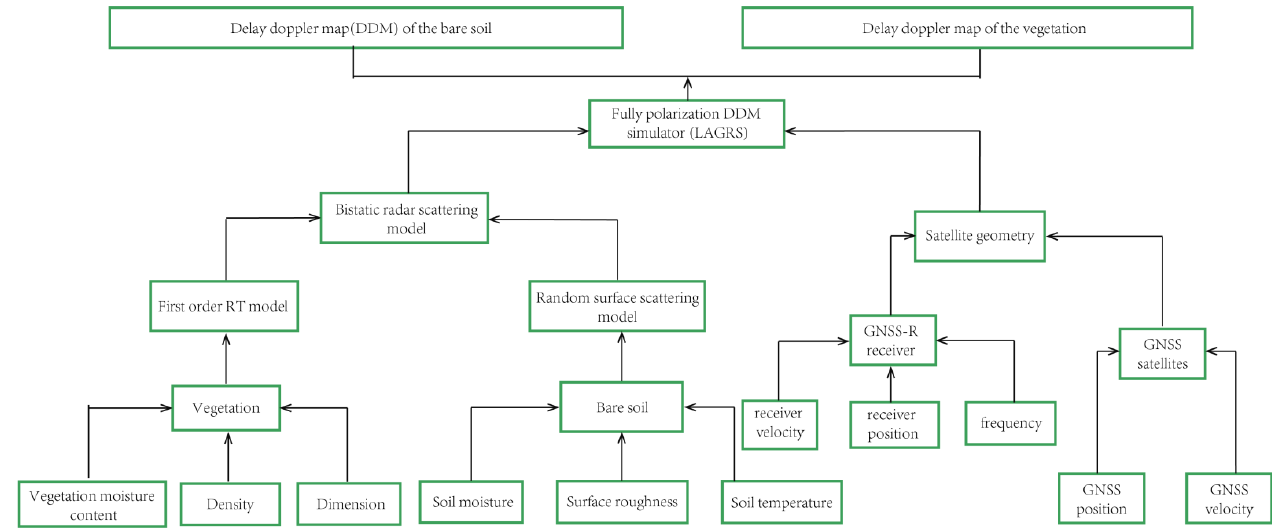
Figure 2. Flowchart of the LAGRS model .